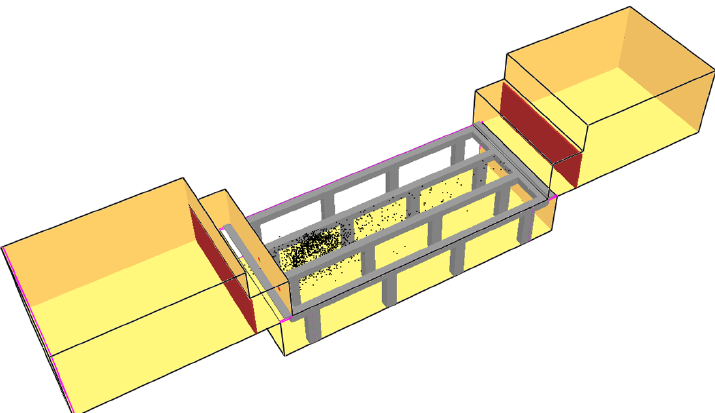
Figure 2. Schematization of the local beneath each coke oven